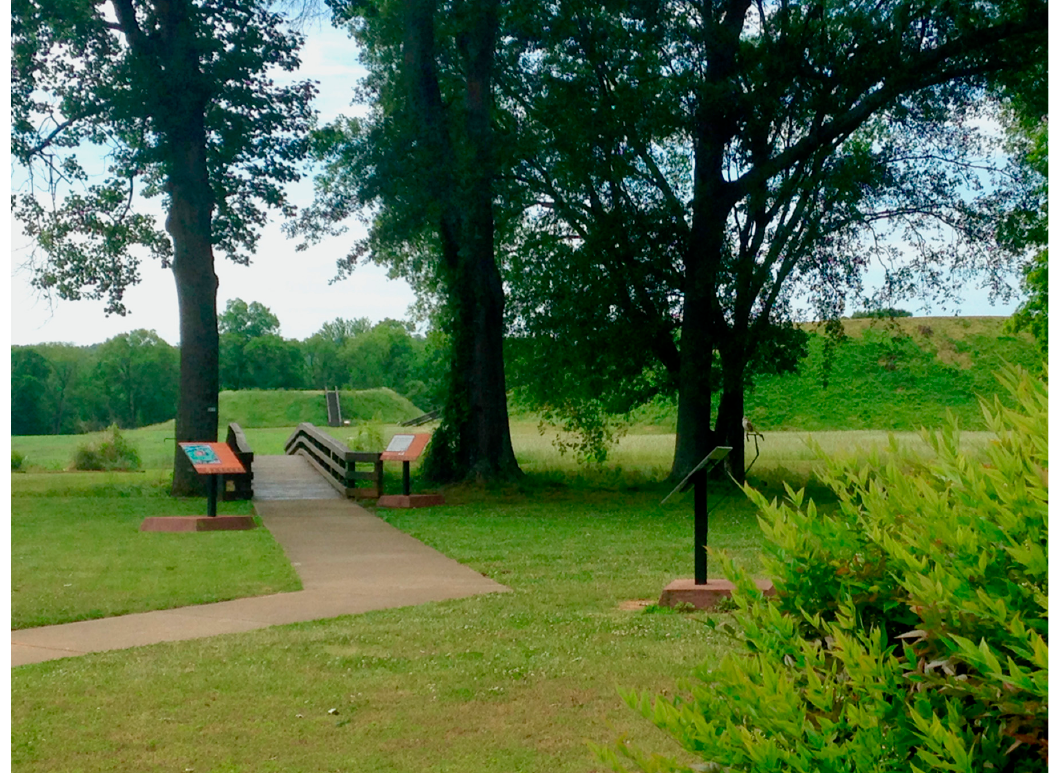
Figure 2. Etowah Mounds, Bartow County, Georgia (c. 1000–1550 CE). Photograph by author.